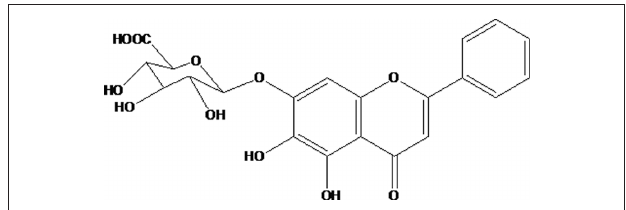
Figure 1 | The chemical structure of